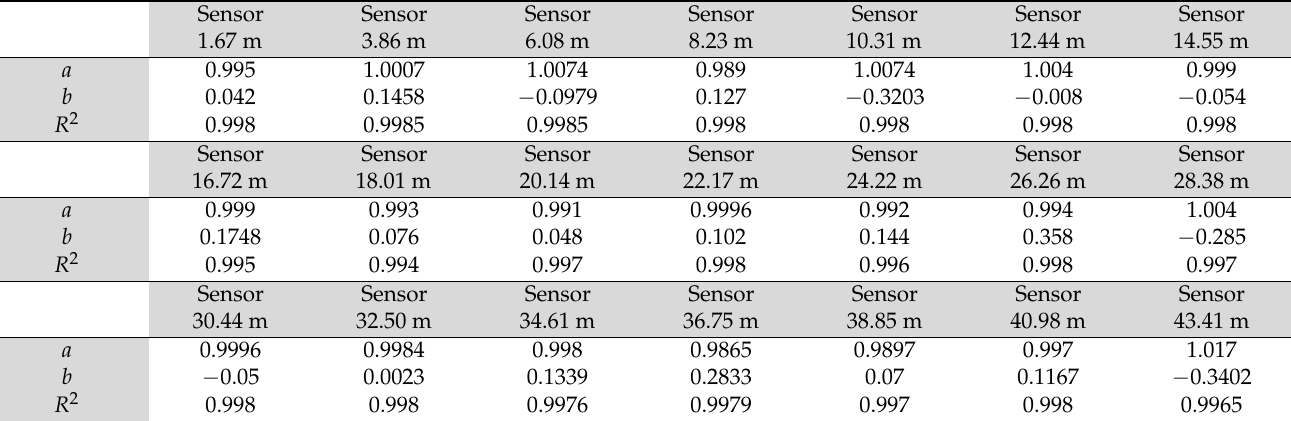
Figure 24. Calibration line for sensor DS18B20 located at 3.86 m. Table 4. DS18B20 calibration